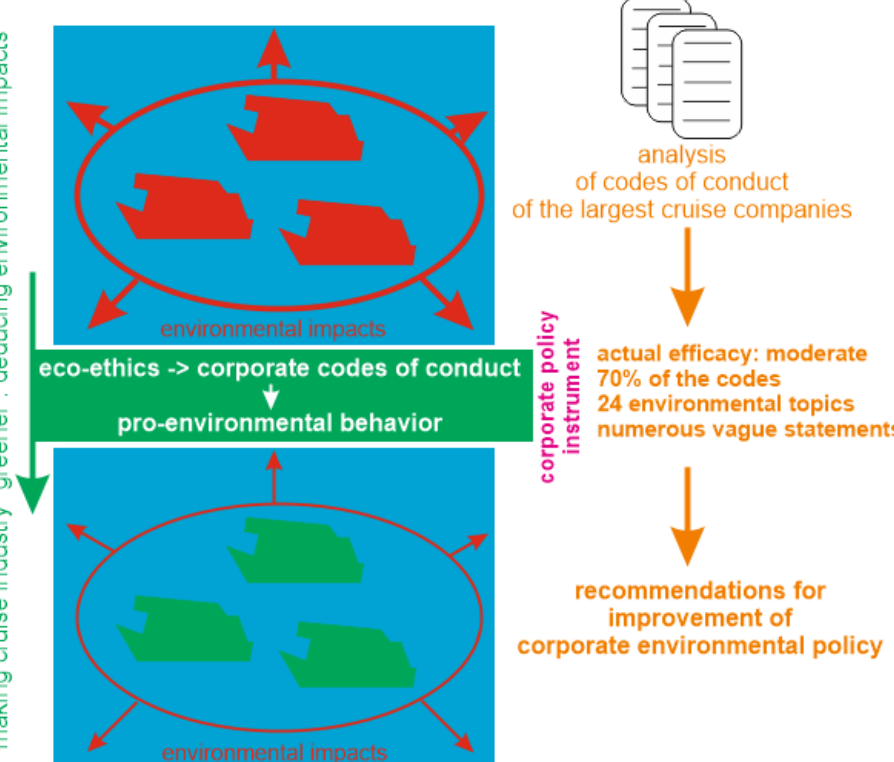
Figure 3. General importance of findings of the present study.